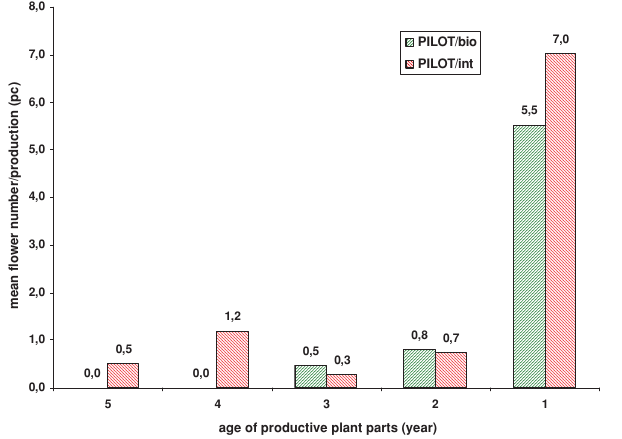
Figure4. Number of inflorescences on the fruiting structures of different age on the variety REMO depending also on the growing technology ( Debrecen- Pallag,